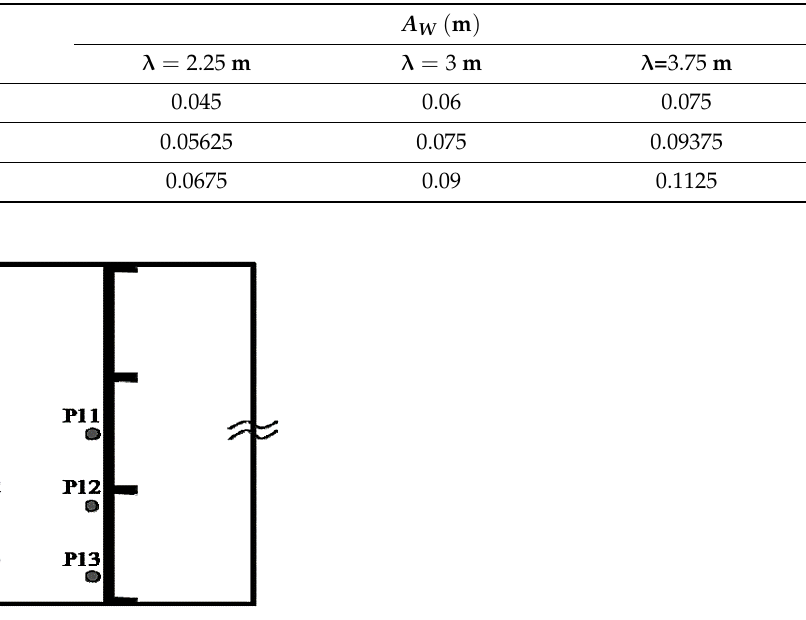
Figure 2. Locations of pressure measurement points on the deck.